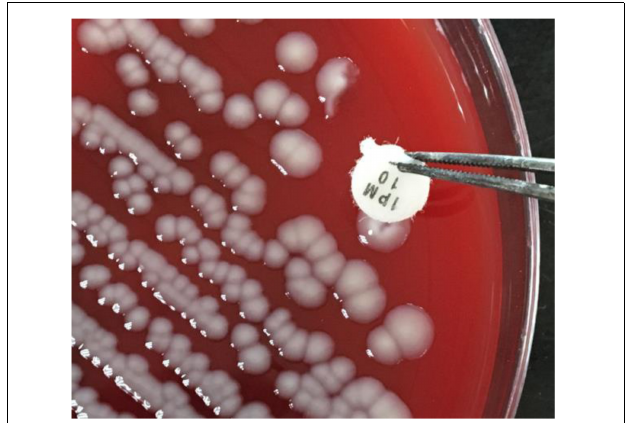
FIGURE 1 | The sCIM testing procedure. Bacteria to be tested were grown overnight on a blood agar plate. One to three overnight colonies were smeared onto an imipenem disk and the disk was then placed on the testing plate.